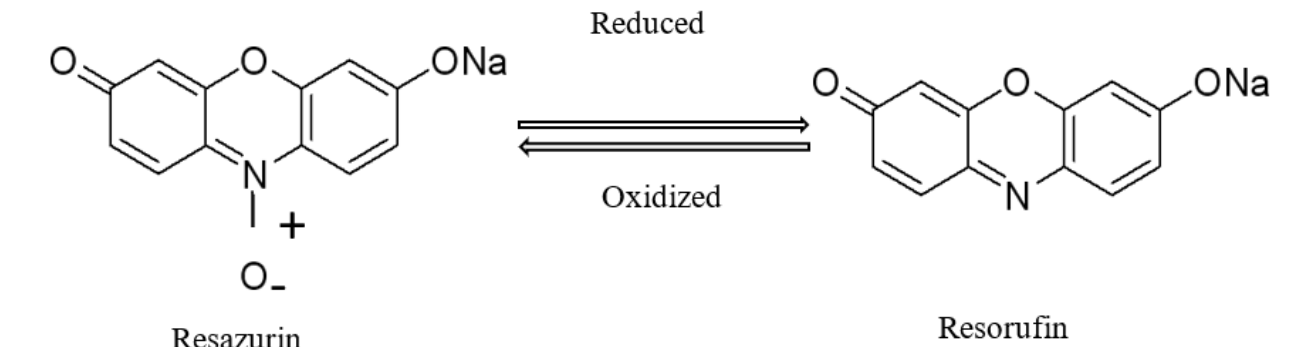
Figure 2. The chemical reaction structures of resazurin and resorufin as a pH indicator. The oxidized form corresponds to resazurin and the reduced form to resorufin. Its change is measured at 517 nm.